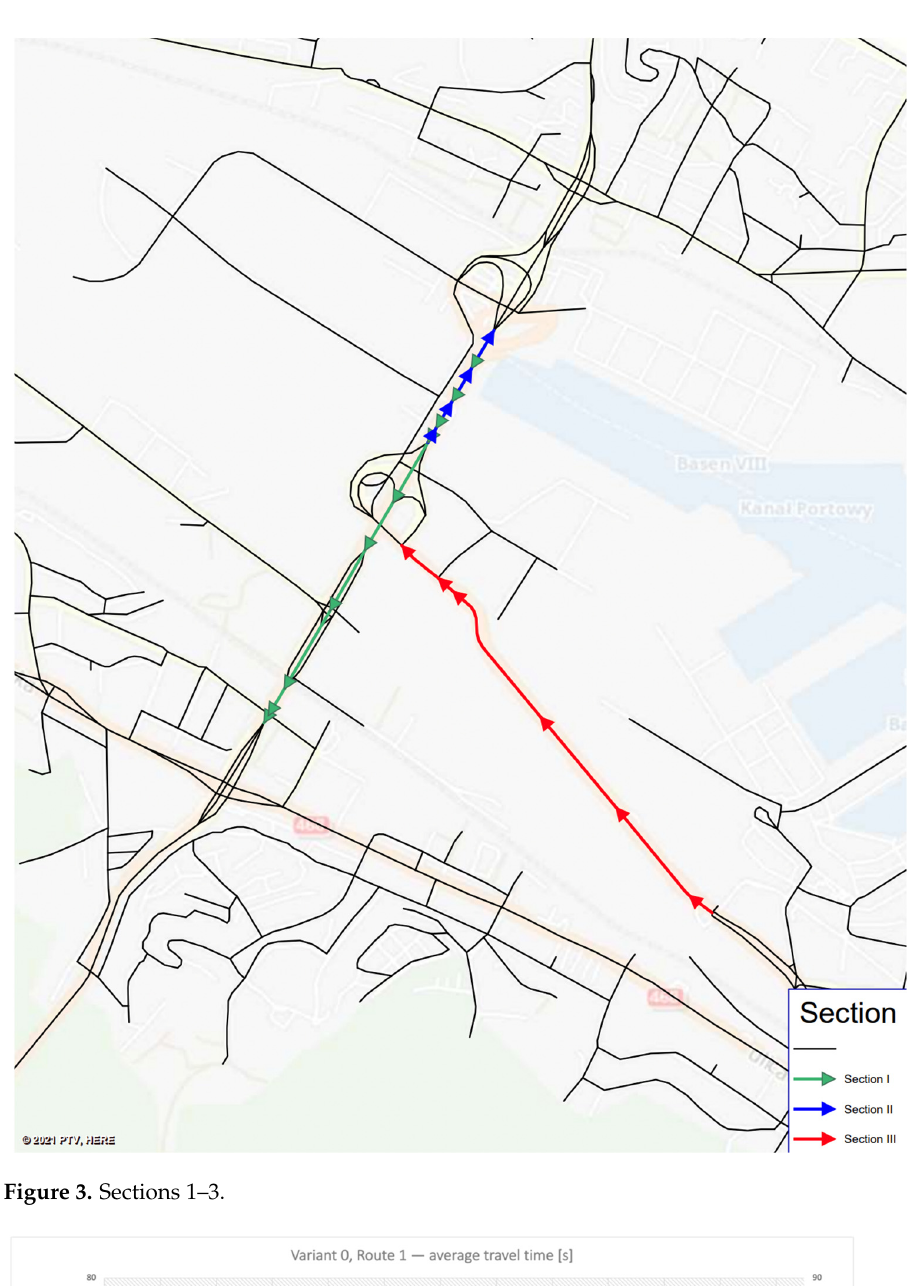
Figure 3. Sections 1–3.